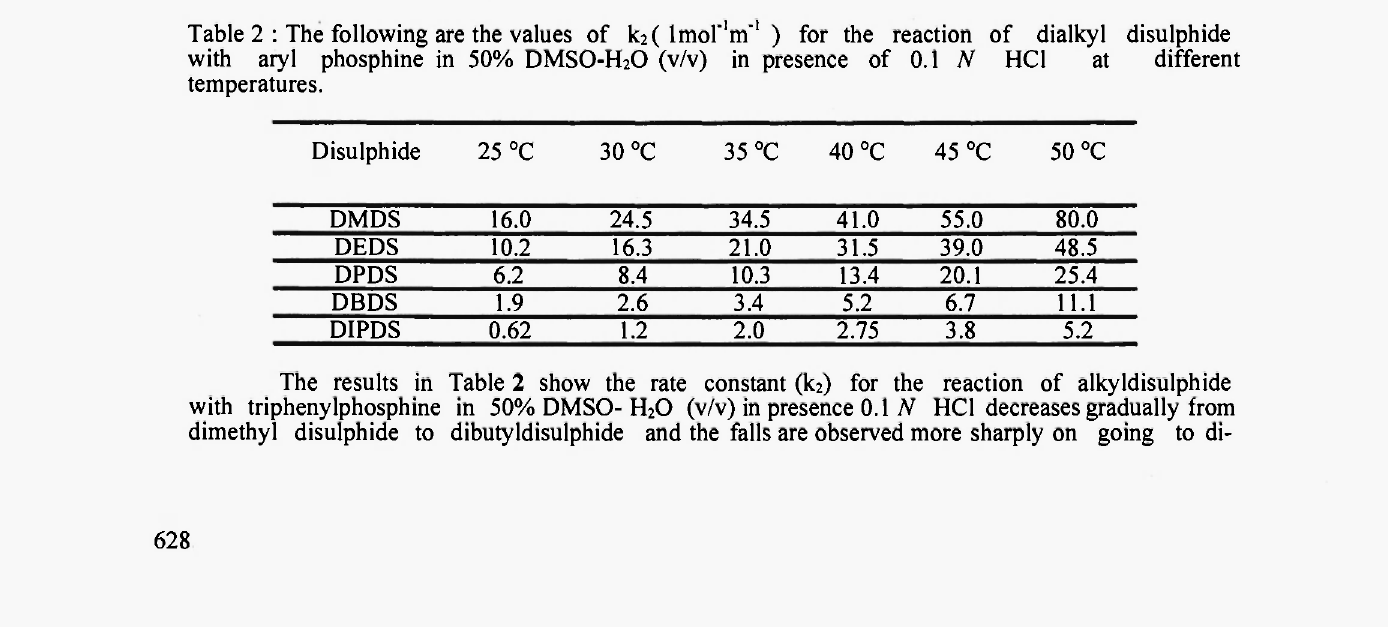
Table 2 : The following are the values of k 2 ( Imor'm" 1 ) for the reaction of dialkyl disulphide with